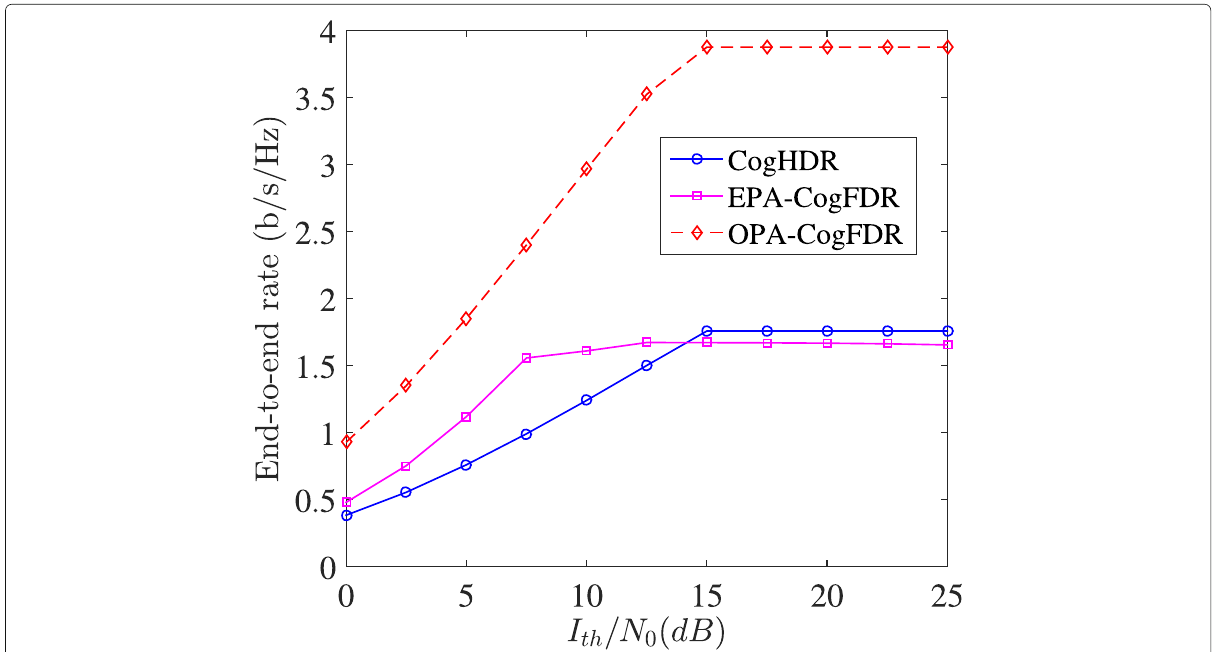
Fig. 10 End-to-end instantaneous rate comparison w.r.t. I th / N 0 ; P / N 0 = 25